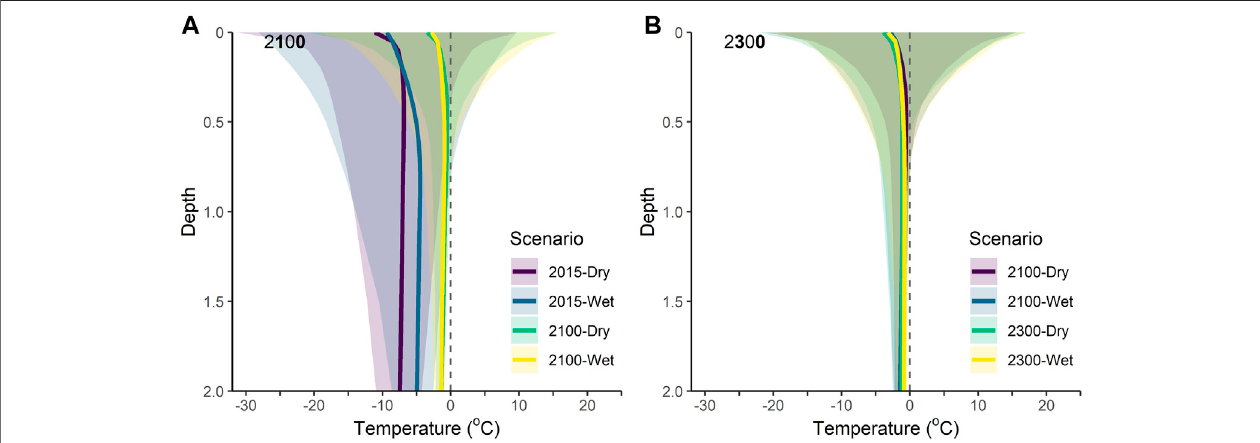
FIGURE3| DistributionofmodeledpeattemperaturesatTKPforDryandWetLandscapescenariosfortimeperiods: (A) 2015(meanfrom2006to2015)and2100 (meanfrom2091to2100); (B) 2100(meanfrom2091to2100)and2300(meanfrom2291to2300).Heavylinesrepresentthemeanannualpeattemperatures,whilethe shaded areas represent the temperature range between the mean minimum annual and mean maximum annual temperature over the periods of interest.